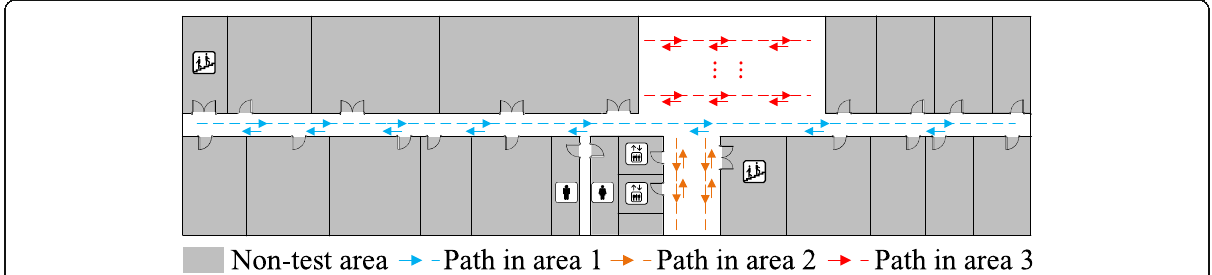
Fig. 3 Schematic diagram of fingerprint collection